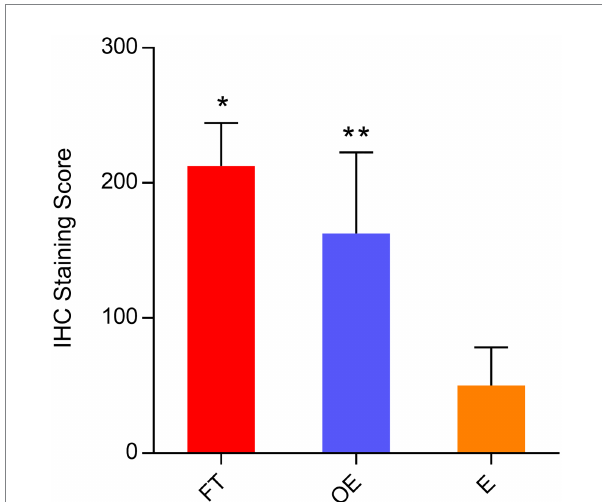
FIGURE 3 FRA protein expression levels by immunohistochemical scores in paired tubal, endometrial, and ovarian endometriosis samples. Comparisons of FRA protein expression levels in the fallopian tube, the endometrium, and the lesions of endometriosis by IHC scores in 32 paired and 18 endometriosis cases (pooled data): FRA expression was significantly higher in the fallopian tube and ovarian endometriosis than that in the endometrium [* p = 0.00051 (FT vs. E) and ** p = 0.00174 (OE vs. E)]. The FRA expression level in the fallopian tube was also higher than the FRA level in the ovarian endometriosis, with the difference just attaining statistical significance ( p = 0.05). FT: fallopian tube; E: endometrium; OE: ovarian